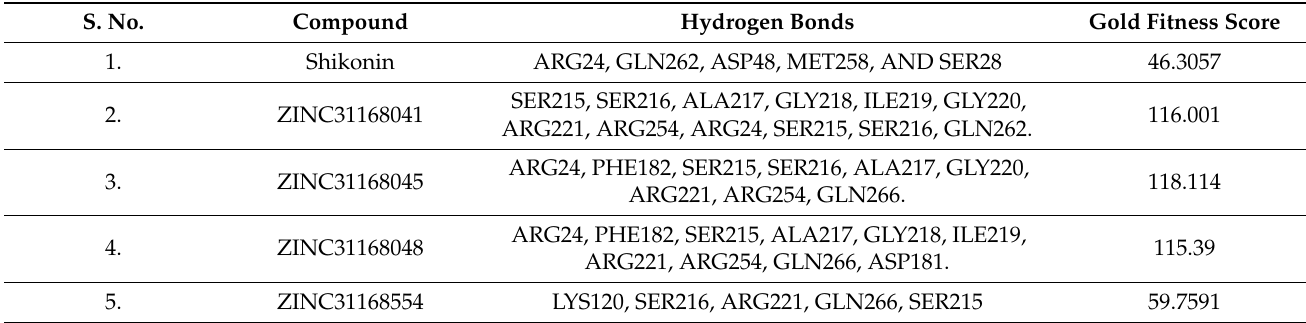
Table 4. Hydrogen bond interactions formed between the complexes of PTP1B-Shikonin, and PTP1B- top 4 filtered molecules within the active site. S.